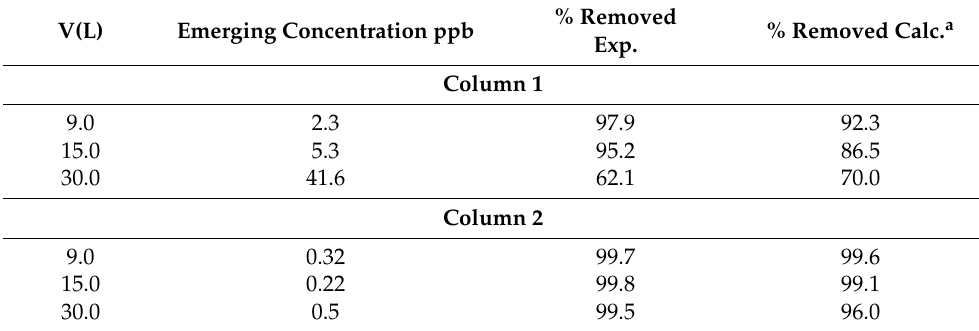
Table 5. Removal of ibuprofen through filtration (average concentration 109.8 ppb) by two columns in series, each including a mixture of a micelle–clay complex with excess sand (1:100, w / w ): Experi- mental and calculated